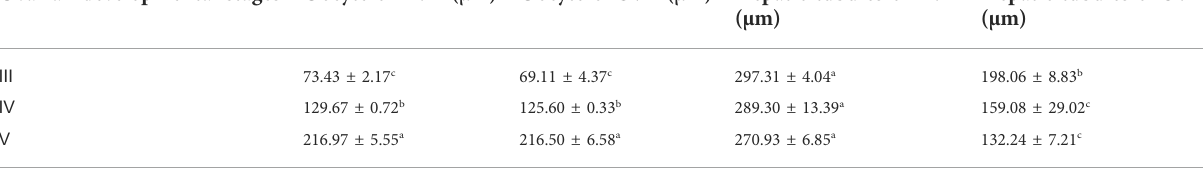
TABLE 3 The dynamics of oocyte and hepatic tubules diameter during the two vitellogenesis periods in S. paramamosain